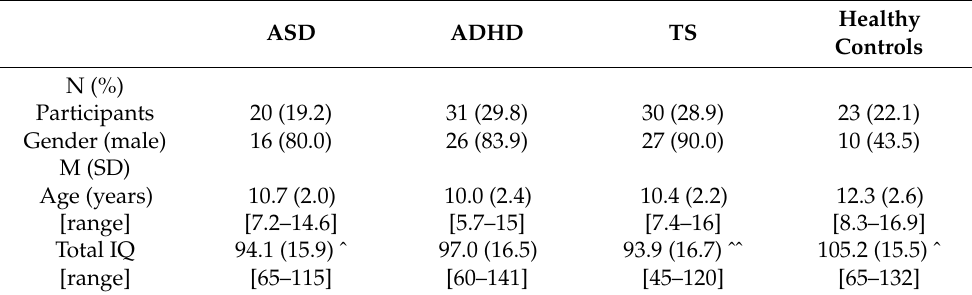
Table 1. Socio-demographic and clinical characteristics of the study participants. ASD ADHD